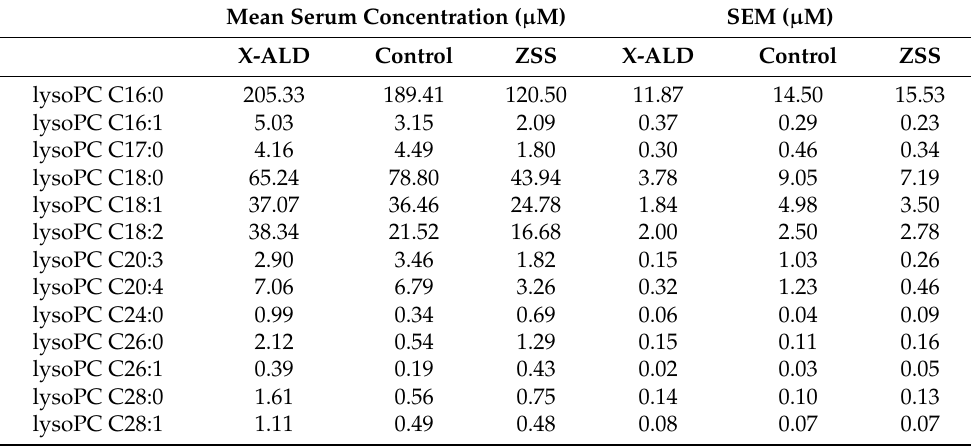
Table A4. Lysophosphatidylcholine species in serum of X-ALD and ZSS patients are elevated com- pared to controls. Serum from patients analyzed using the Biocrates AbsoluteIDQ p180 kit. Concen- trations of lysophosphatidylcholine species (lysoPC) in µ M, n = 36 (X-ALD/ ABCD1 ), 28 (Controls), 17 (ZSS/ PEX1